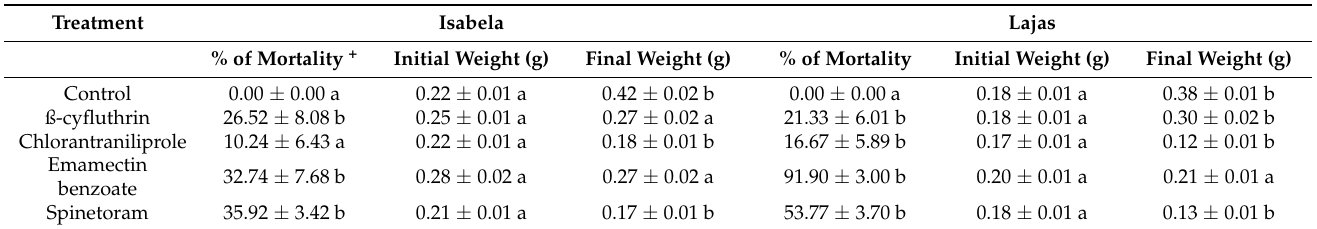
Table 8. Mean ( ± SE) of percentages of mortality for corn earworm ( Helicoverpa zea (Boddie) (Lep- idoptera: Noctuidae)) larvae and their initial and final weight evaluated at 96 h after insecticide application in